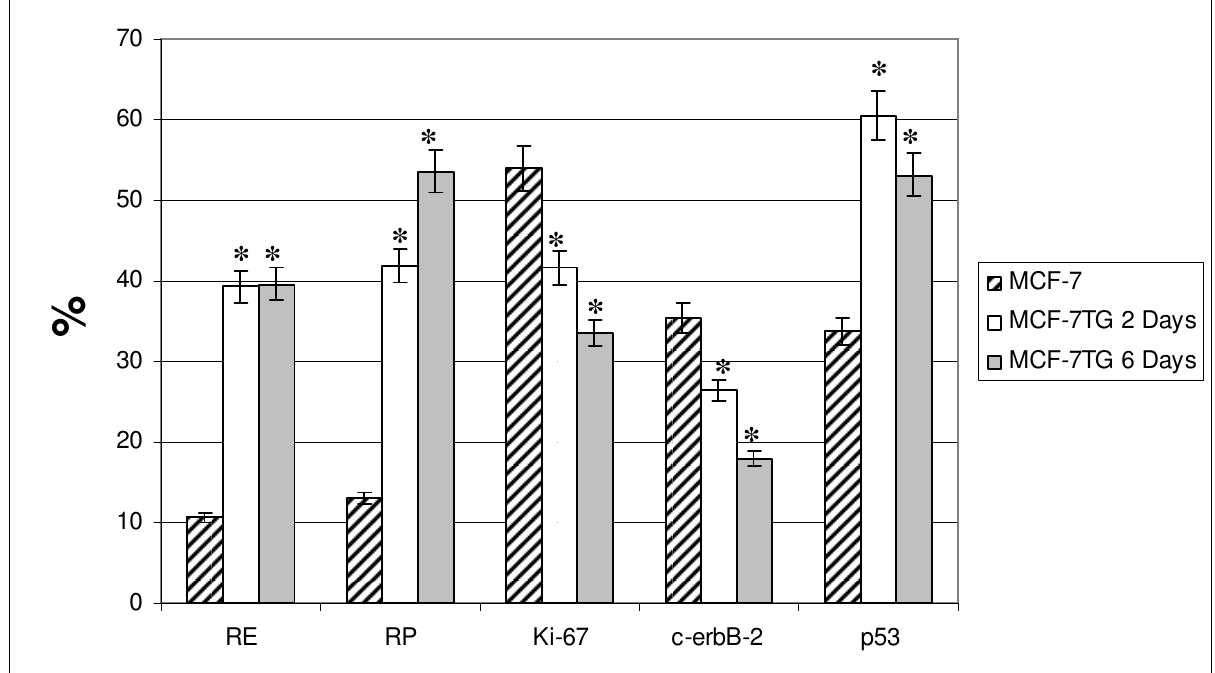
Figure 6. FACScan analysis of modifications in the expression of proteins in MCF-7TG cells treated with dexamethasone (1 mM) for 2 and 6 days. The asterisk means statistically